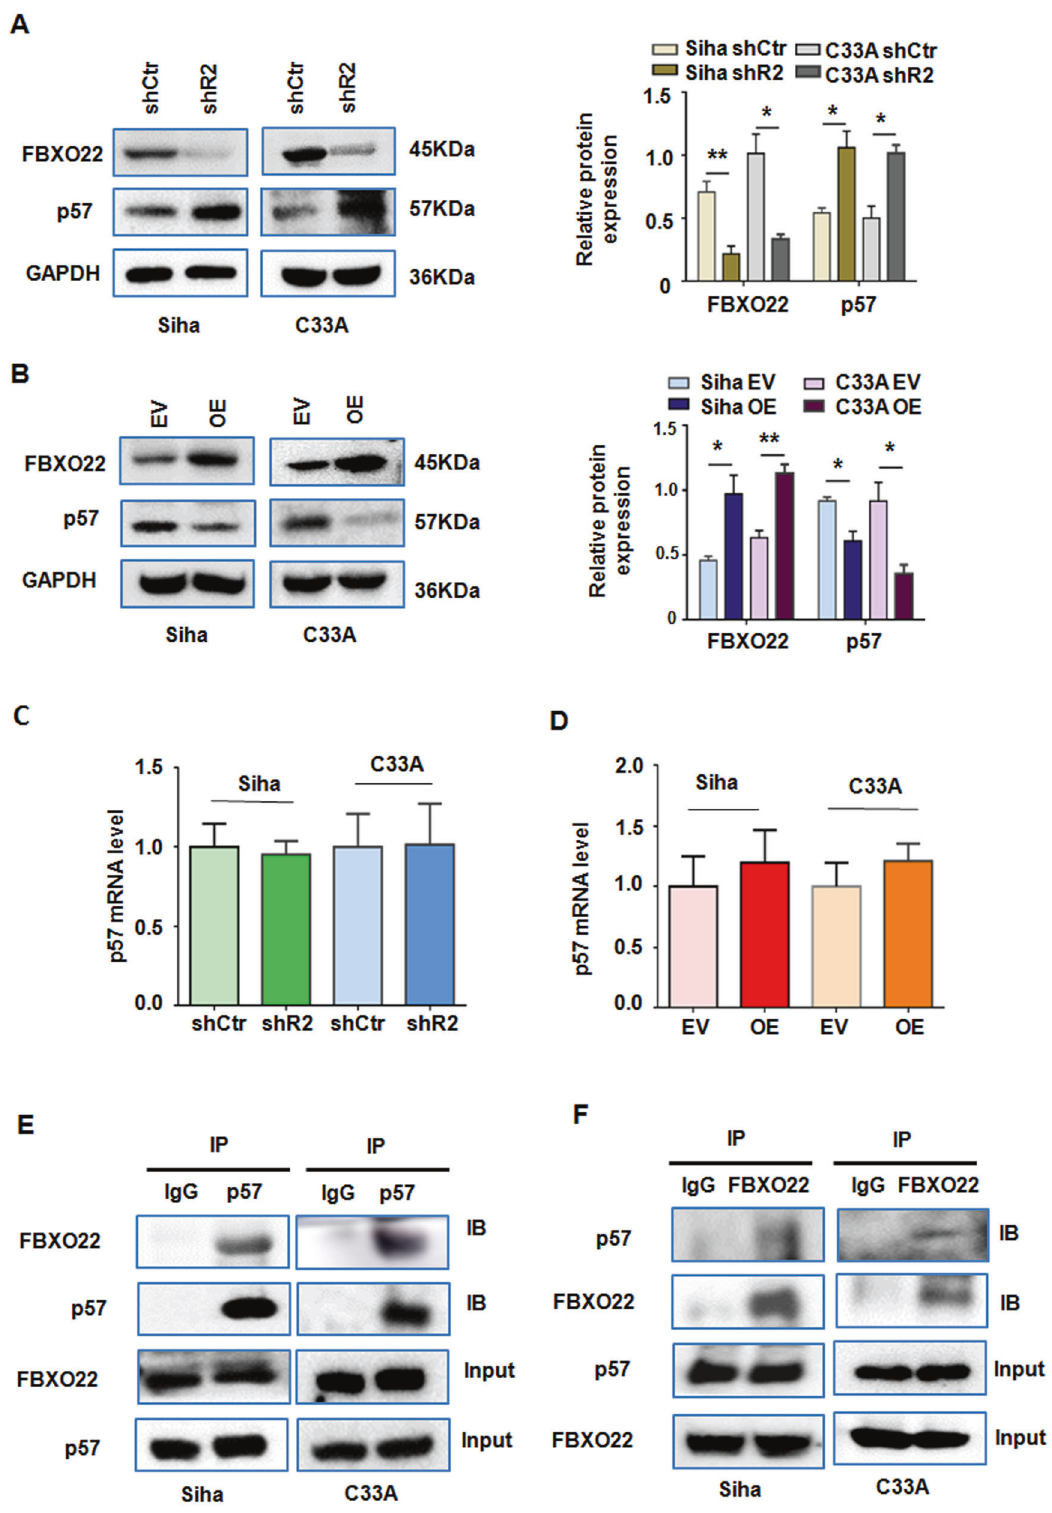
Fig. 5 FBXO22 regulates p57Kip2 protein level and physically interacts with p57Kip2. A , B FBXO22 knockdown increased p57 protein expression ( A ) and its ectopic expression reduced p57Kip2 protein expression ( B ) in SiHa and C33A cells detected by Western blotting analysis. Relative FBXO22 and p57Kip2 protein level is presented as normalized band density to the corresponding GAPDH band density. Each data in the plots is the mean ± SEM from three independent Western blots. * P < 0.05, ** P < 0.01. shCtr: control shRNA, shR2: shFBXO22-2, EV: empty vector, OE: FBXO22 overexpression. C , D FBXO22 knockdown ( C ) or overexpression ( D ) showed no effect on the p57Kip2 mRNA expression in SiHa and C33A cells. Each data in the plots are expressed as the means ± SEM from triplicate measurements. E , F FBXO22 and p57Kip2 proteins physically interact with each other in SiHa and C33A cells by IP assays as detected by immunoblotting (IB) for FBXO22 in the precipitated proteins by an anti-p57Kip2 antibody ( E ) and for p57Kip2 in the precipitated proteins by an anti-FBXO22 antibody ( F ). Cell Death and Disease (2022)